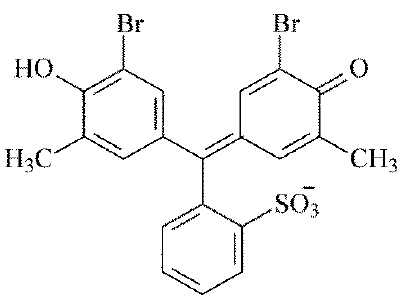
Figure 2. Bromocresol purple structure at pH 7.0.